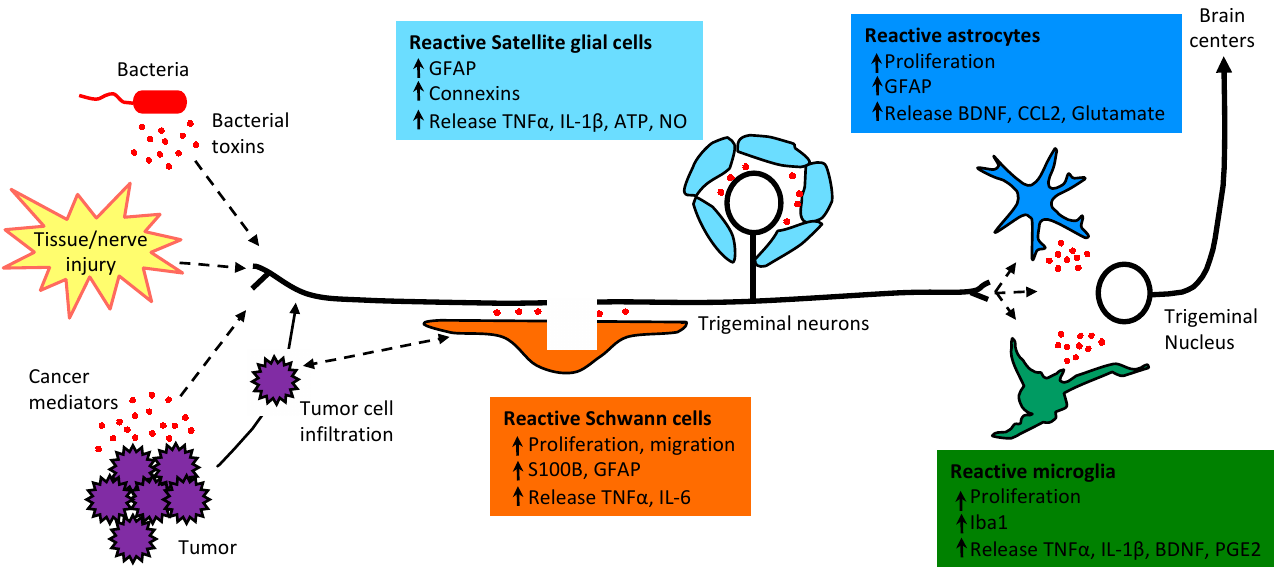
Figure 1. Functional alterations of glial cells, including Schwann cells, SGCs, astrocytes and microglia in response to rofacial tumors, bacterial toxins, dental pulp injury or tissue/nerve injury. Peripheral injury/inflammation induces an increase in glial cell proliferation and hypertrophy, changes in glial activation markers, and the release of pronociceptive mediators that can contribute to neuronal sensitization and pain. TNF α : tumor necrosis factor alpha, IL: interlukin; NO: nitrogen oxide; BDNF: brain derived neurotrophic factor; CCL2: C-C motif chemokine ligand 2; PGE2: prostaglandin E2.